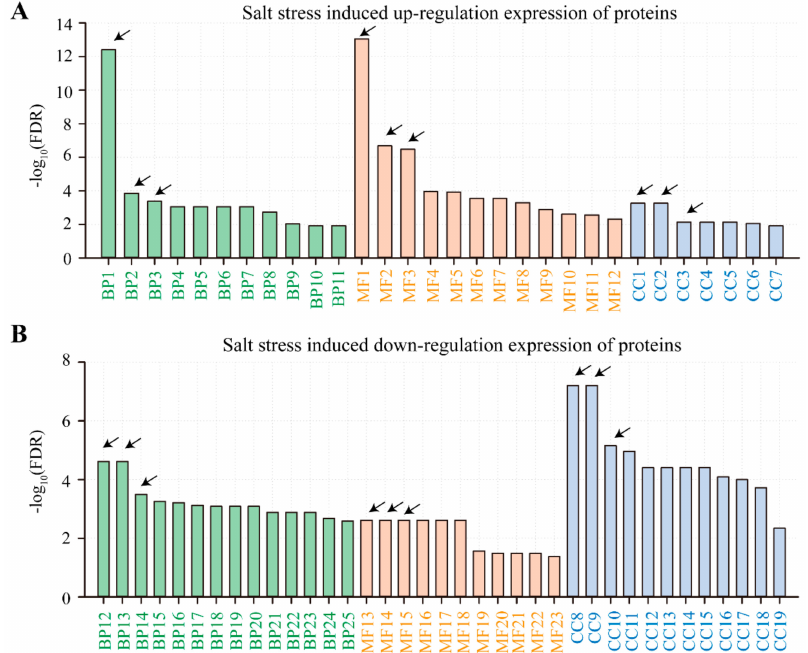
Figure 4. Kyoto encyclopedia of genes and genomes (KEGG) analysis on salt stress induced up- / down-regulation of expressed proteins. Panels ( A , B ) represent up- / down-regulation of proteins induced by 200 mM NaCl treatment in alfalfa seedlings for 14 d. Abbreviations: BP1-11 (biological process). MF1-12 (molecular function). CC1-7 (cellular components). The top 3 biological pathways were presented as follows for up-regulated proteins: (1) BP1 (biological process), oxidation-reduction process; BP2, hydrogen peroxide catabolic process; BP3, response to abscisic acid; (2) MF1 (molecular function), glutathione transferase activity; MF2, heat-responsive proteins; MF3, electron transporting oxidoreductase; (3) CC1-7 (cellular components)—chloroplast, plastid stroma, chloroplast